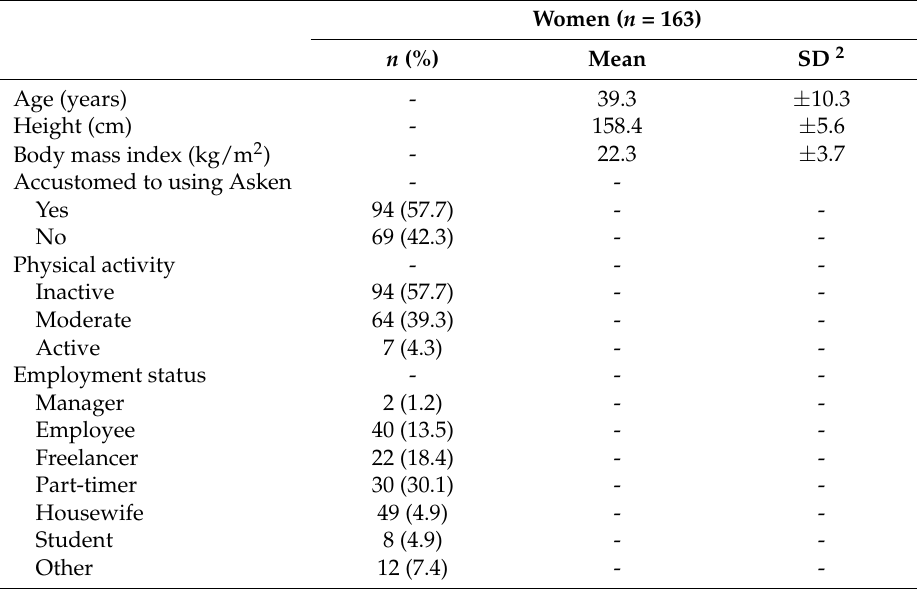
Table 1. Participant characteristics 1 .